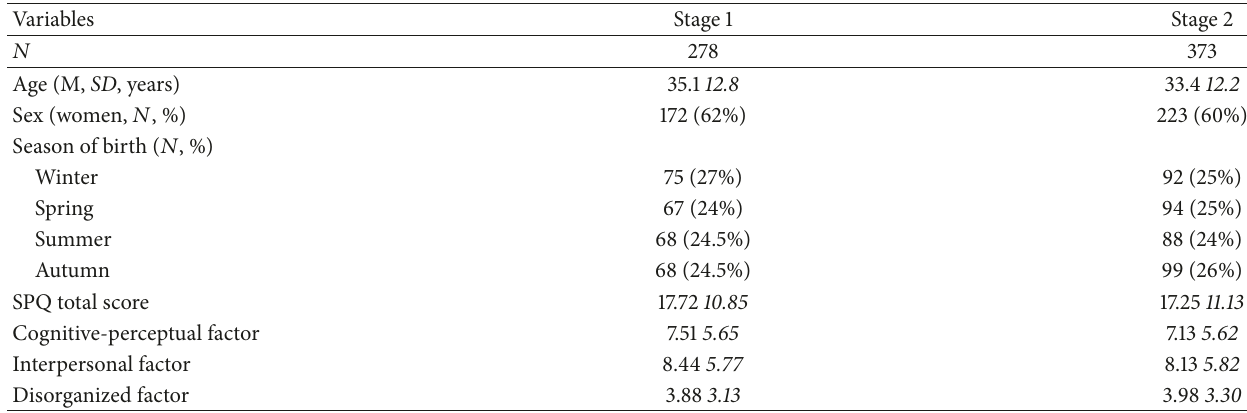
Table 1: Sociodemographic characteristics of